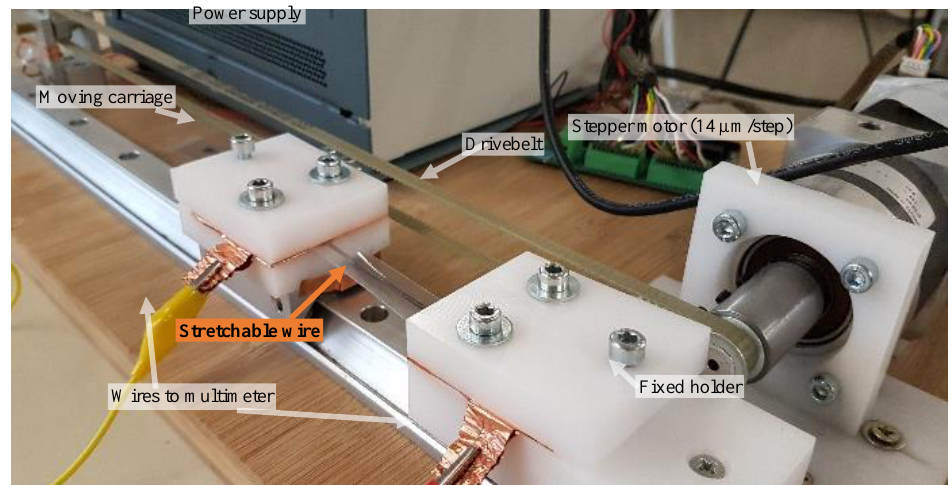
Figure 1. Characterization setup with a stretchable wire between the moving carriage and the fixed holder.